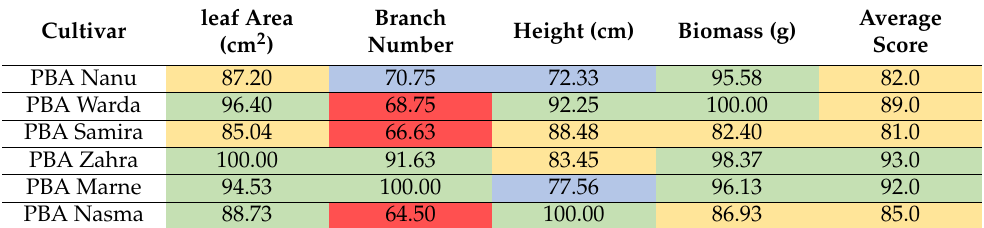
Table 8. Comparison of growth measures of different faba bean cultivars grown in Toowoomba. For each trait, a percentage score and a colour code is assigned to each cultivar based on the relative value of trait attained. Cells are coloured to indicate likely competitiveness as follows <70 = red (poorly competitive), 71—80 = blue (moderately competitive), 81—90 = yellow (highly competitive), >90 = green (very highly competitive).